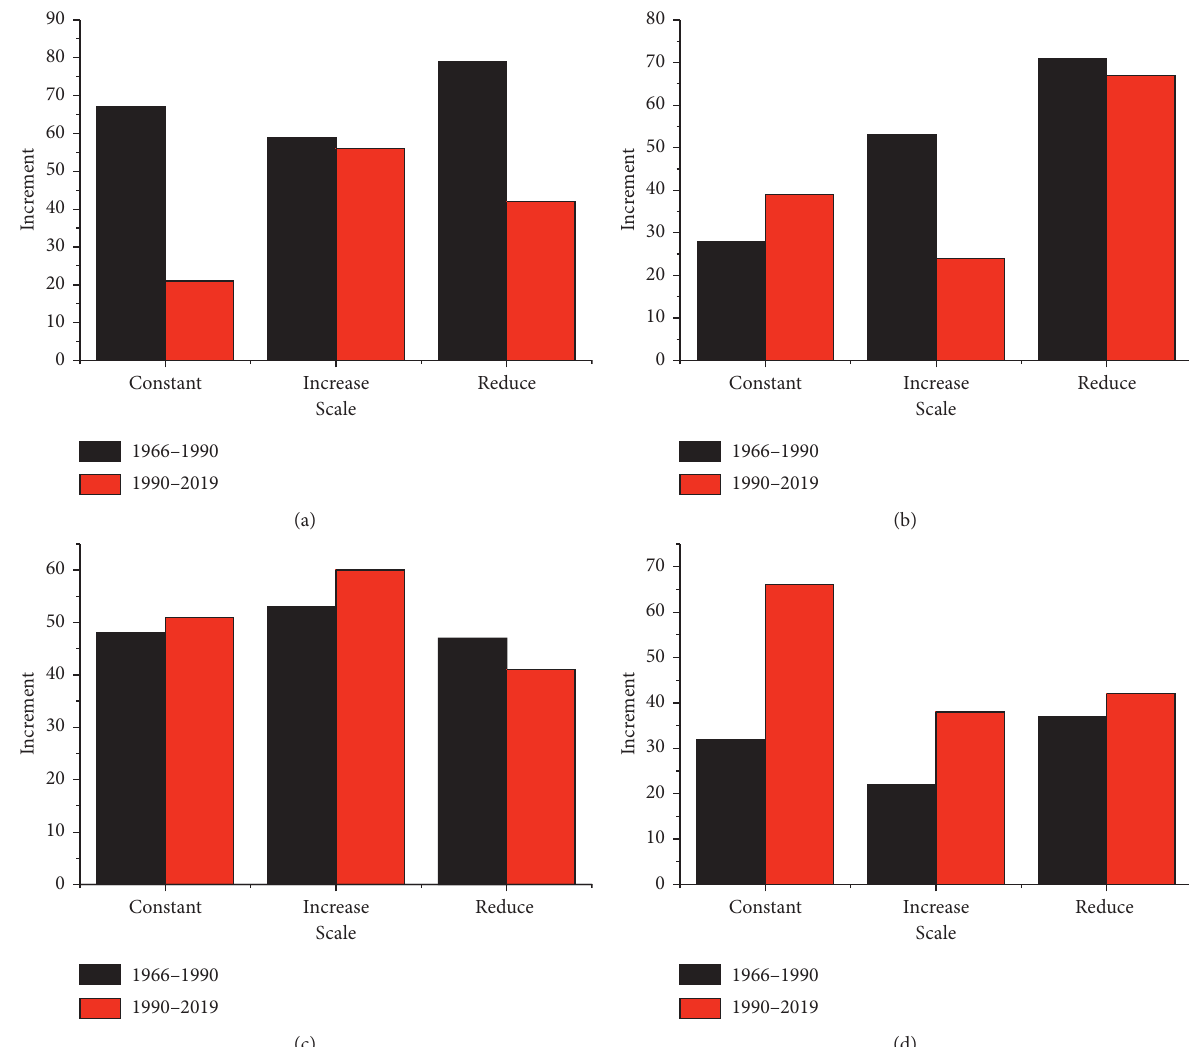
Figure 6: Statistics of the three basic patterns of urban development in each geographical type zone. (a) Mountain. (b) Hilly. (c) Flat. (d)